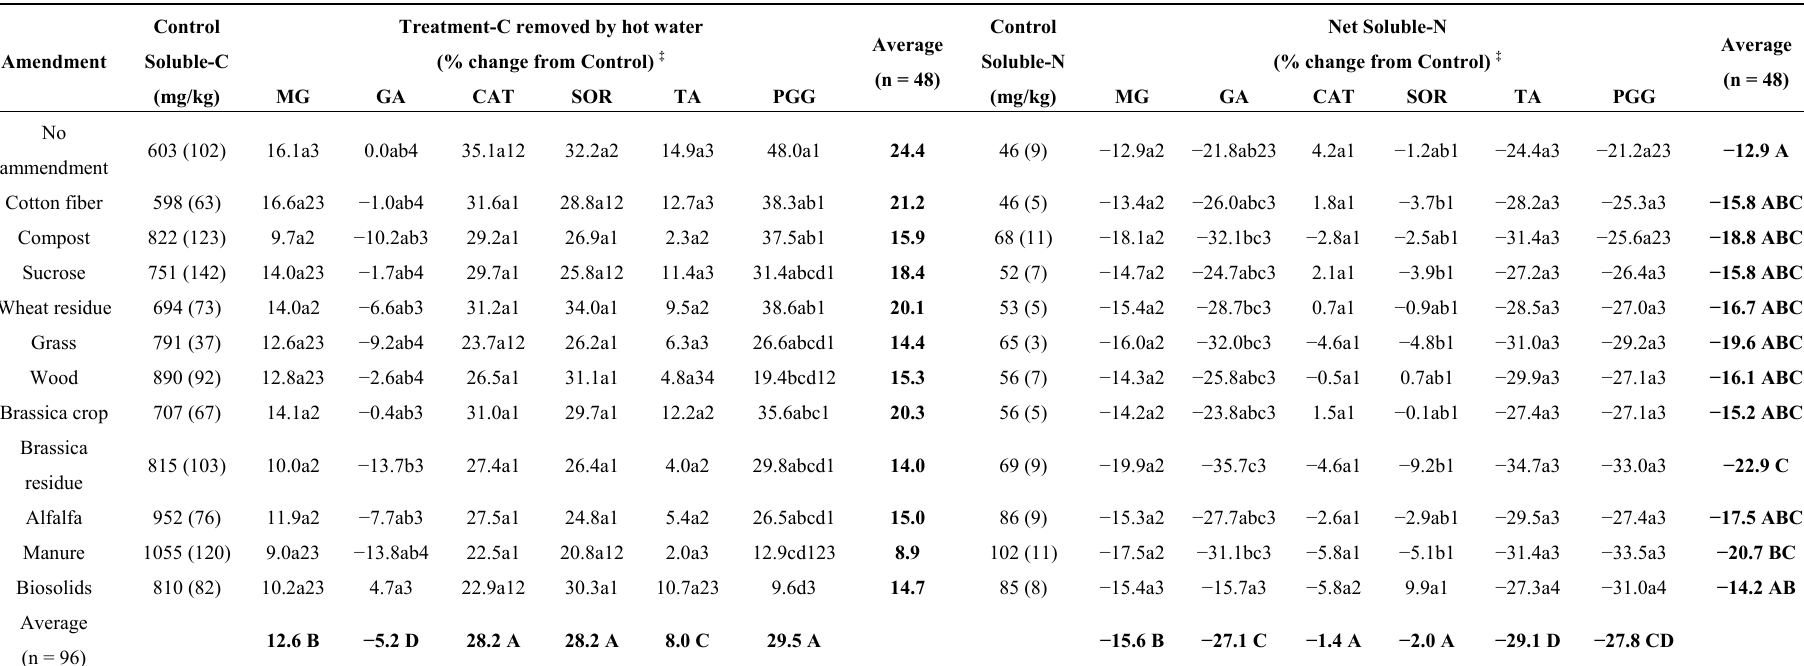
Table 4. Response of soils from Pendleton amendment field study at Columbia Plateau Conservation Research Center, Pendleton, OR to addition of treatment compounds with a 1 hour shake at room temperature followed by a hot-water treatment †